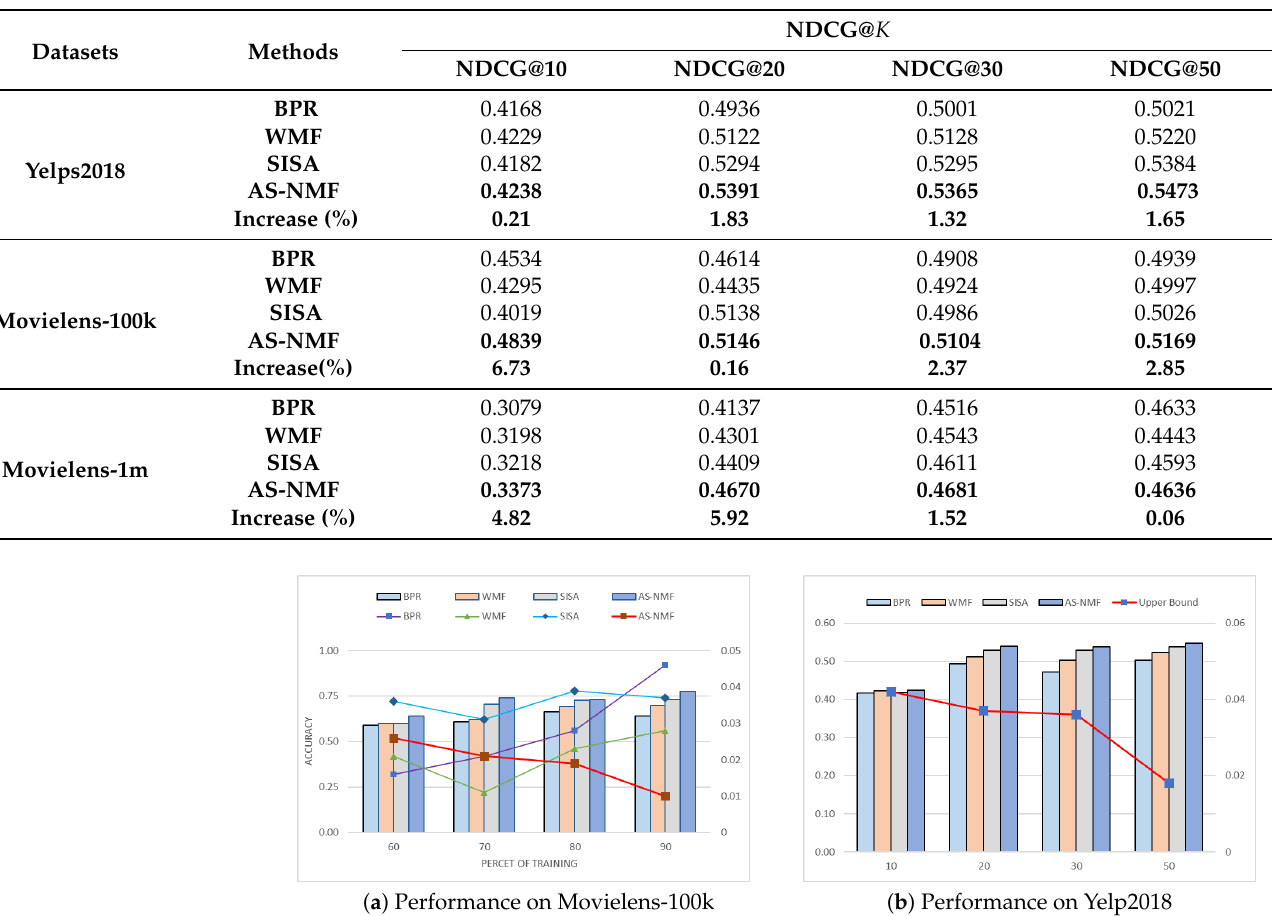
Figure 2. The performance comparison on different training set partitions and top- K on Yelp2018 and Movielens-1m datasets. Impact of the shard number on the recommendation efficiency and performance on Yelp2018 and Movielens-100k datasets. The bar chart shows the recommendation performance and the line chart shows the stability of different